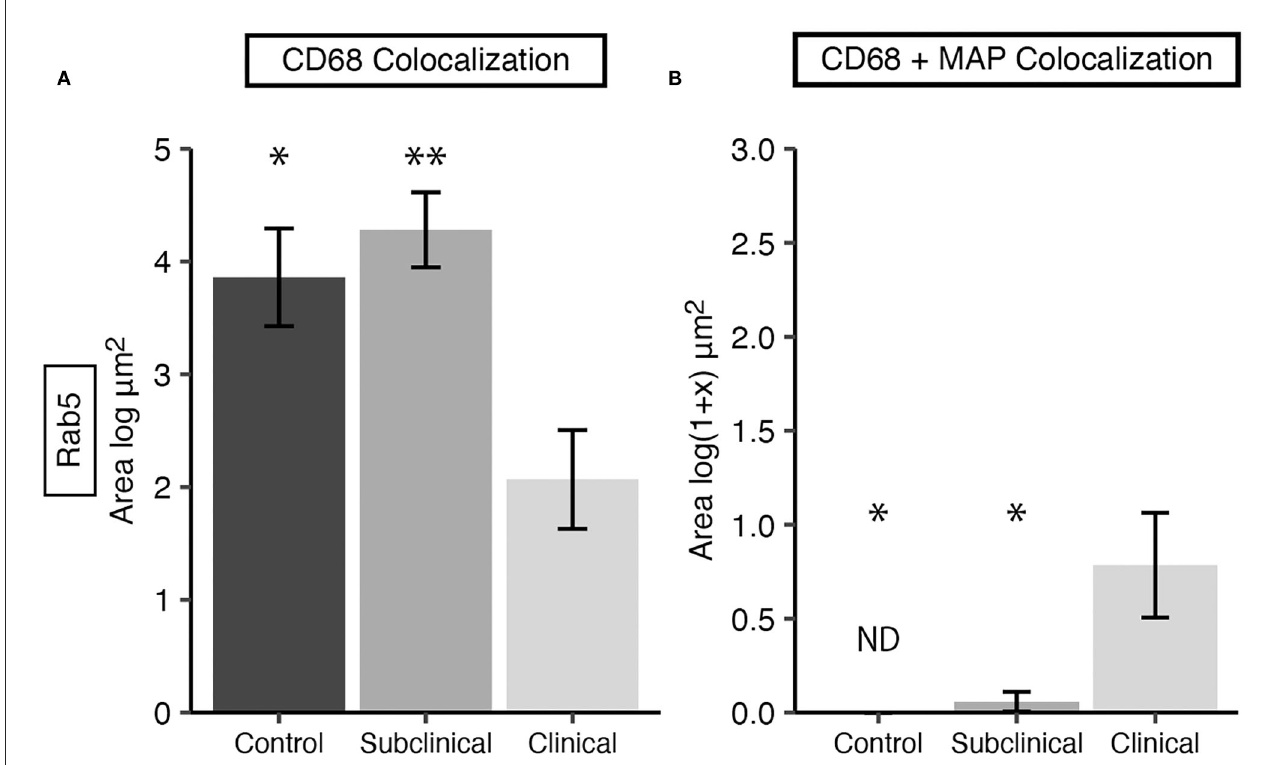
FIGURE3 Early endosomal marker Rab5 expression in frozen tissue sections from bovine mid-ileum. Cows were grouped according to stage of paratuberculosis infection (clinical n = 9, subclinical n = 9, JD- control n = 8). (A) Rab5 expressed within CD68 + macrophages, presented as the mean fluorescence area (log µ m 2 ) ± SE. (B) Rab5 and MAP colocalization within CD68 + macrophages, presented as the mean fluorescence area [log(1 + x) µ m 2 ] ± SE. Significance is indicated as * < 0.05 and ** < 0.01 compared to the clinical group and non-detected measurements are indicated by